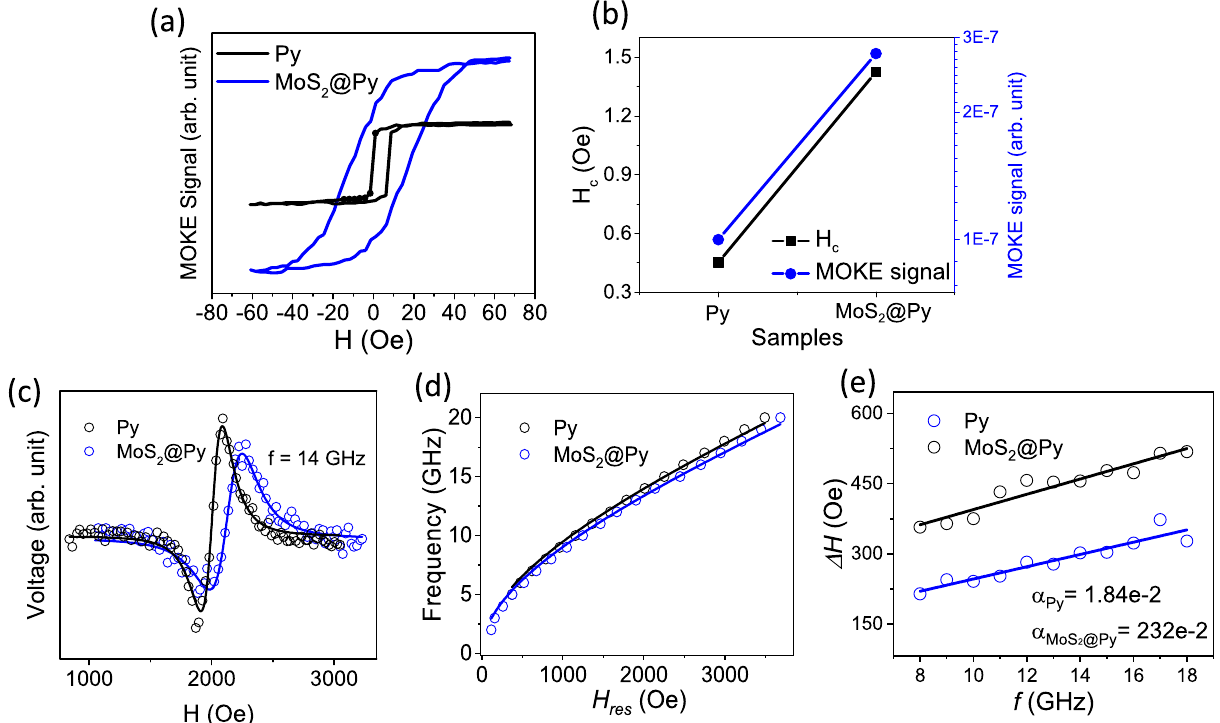
Figure 3. ( a ) MOKE signal measured for the samples and ( b ) comparison of the H c and the MOKE signal intensity of the samples. ( c ) the FMR signal observed at f = 14 GHz, ( b ) the fitted f and H res curve based on Kittel formula and ( c ) the data of FWHM versus f and their fitting based on the damping relation.